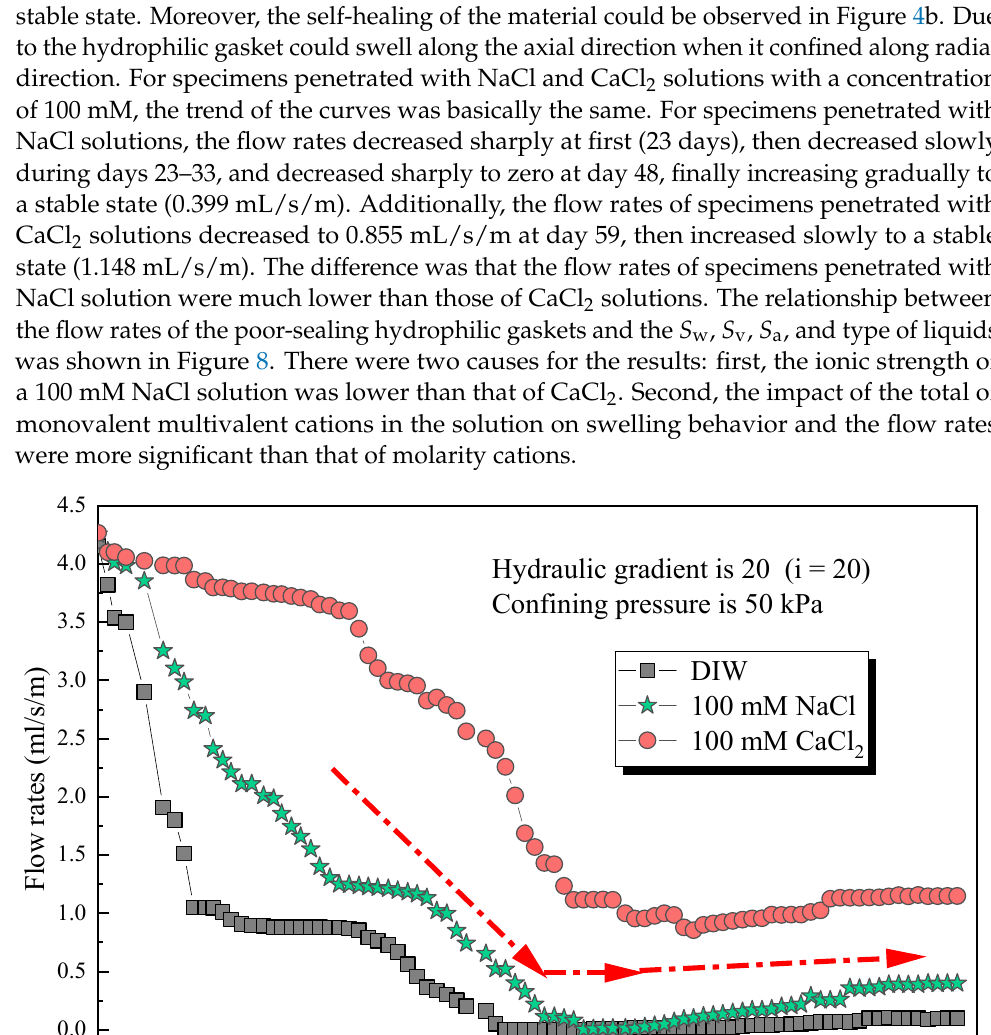
Figure 8. The relationship between the flow rates of the poor-sealing hydrophilic gaskets and the S w , S v , S a , and type of liquids.